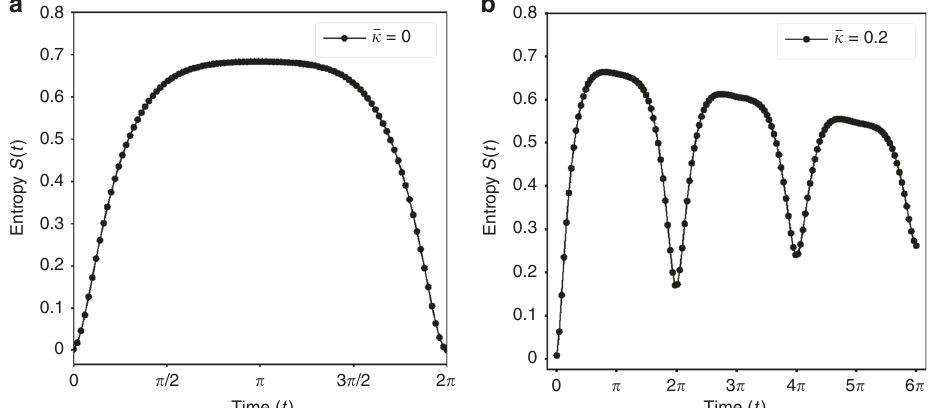
Fig. 3 Linear entropy of the traced-out cavity state. Plots showing the linear entropy S ( t ) for a free evolution and b noisy evolution with photon dissipation rate (cid:2) κ ¼ κ = ω m ¼ 0 : 2. Both cases have been plotted for values (cid:2) κ ¼ (cid:2) g ¼ α ¼